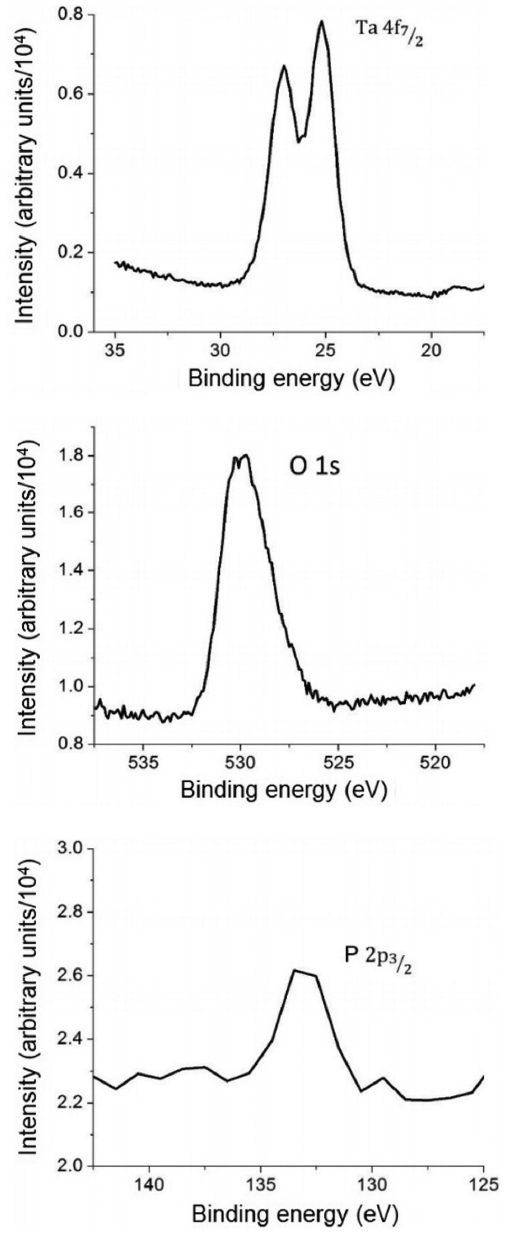
PO . 3 4 SO and H PO (1 mol.L -1 ). 2 4 3 4